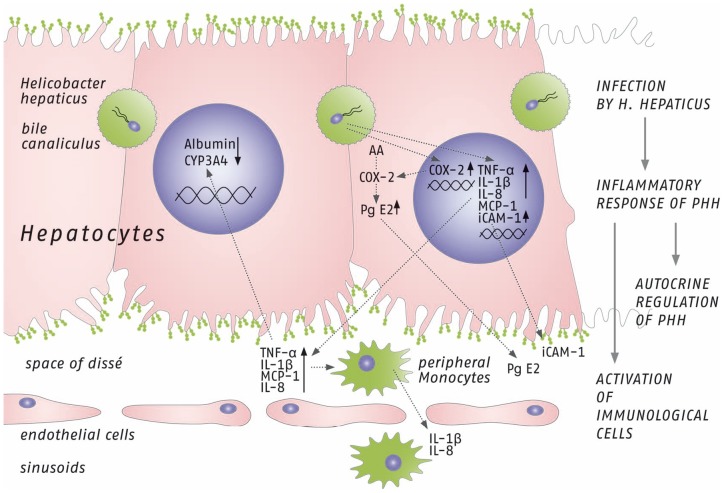
Schematic illustration showing the potential mechanism of the inflammatory response induced by H. hepaticus in PHH, summarizing main findings of this study.
In vivo, infection of hepatocytes by H. hepaticus is thought to mainly occur via bile canaliculi, initiating an inflammatory response of PHH. First, gene expression of acute phase cytokines is induced (Monocyte chemotactic protein 1 (MCP-1), Interleukin 8 (IL-8), Tumor necrosis factor alpha (TNF-alpha) and Interleukin 1 beta (IL-1 beta)) and their perihepatic concentrations increase. Additionally, mRNA expression of cyclooxygenase 2 (COX-2) and intercellular adhesion molecule-1 (ICAM-1) are increased, resulting in higher perihepatic Prostaglandin E2 (PGE2) concentration and increased ICAM-1 incorporation into the cell membrane of hepatocytes. In a second step of the in vivo reaction sequence, peripheral monocytes are attracted and activated by newly synthetized acute phase cytokines, followed by induction of monocyte gene expression of Interleukin 1 beta (IL-1 beta) and Interleukin 8 (IL-8). Furthermore, acute phase cytokines most probably contribute to the downregulation of gene expression of albumin and cytochrome P450 3A4 of hepatocytes in an autocrine fashion. (AA  =  arachidonic acids).